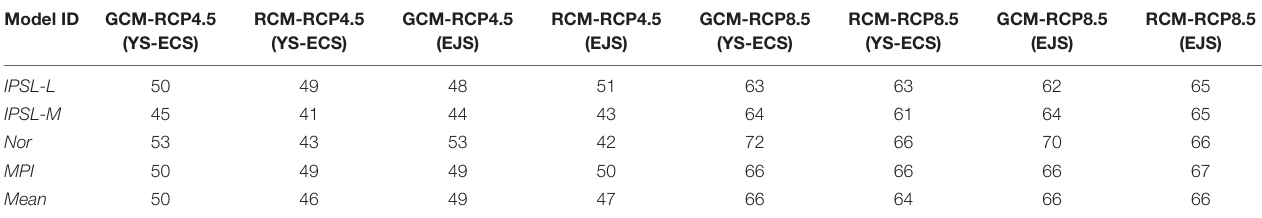
TABLE 3 | Sea-level rise (SLR; unit: cm) of GCMs and RCMs between 1986–2005 and 2081–2100 ( Figures 9 , 10 ) in the shallow (YS-ECS) and deep seas (EJS), under RCP 4.5 and RCP 8.5 scenarios. Model